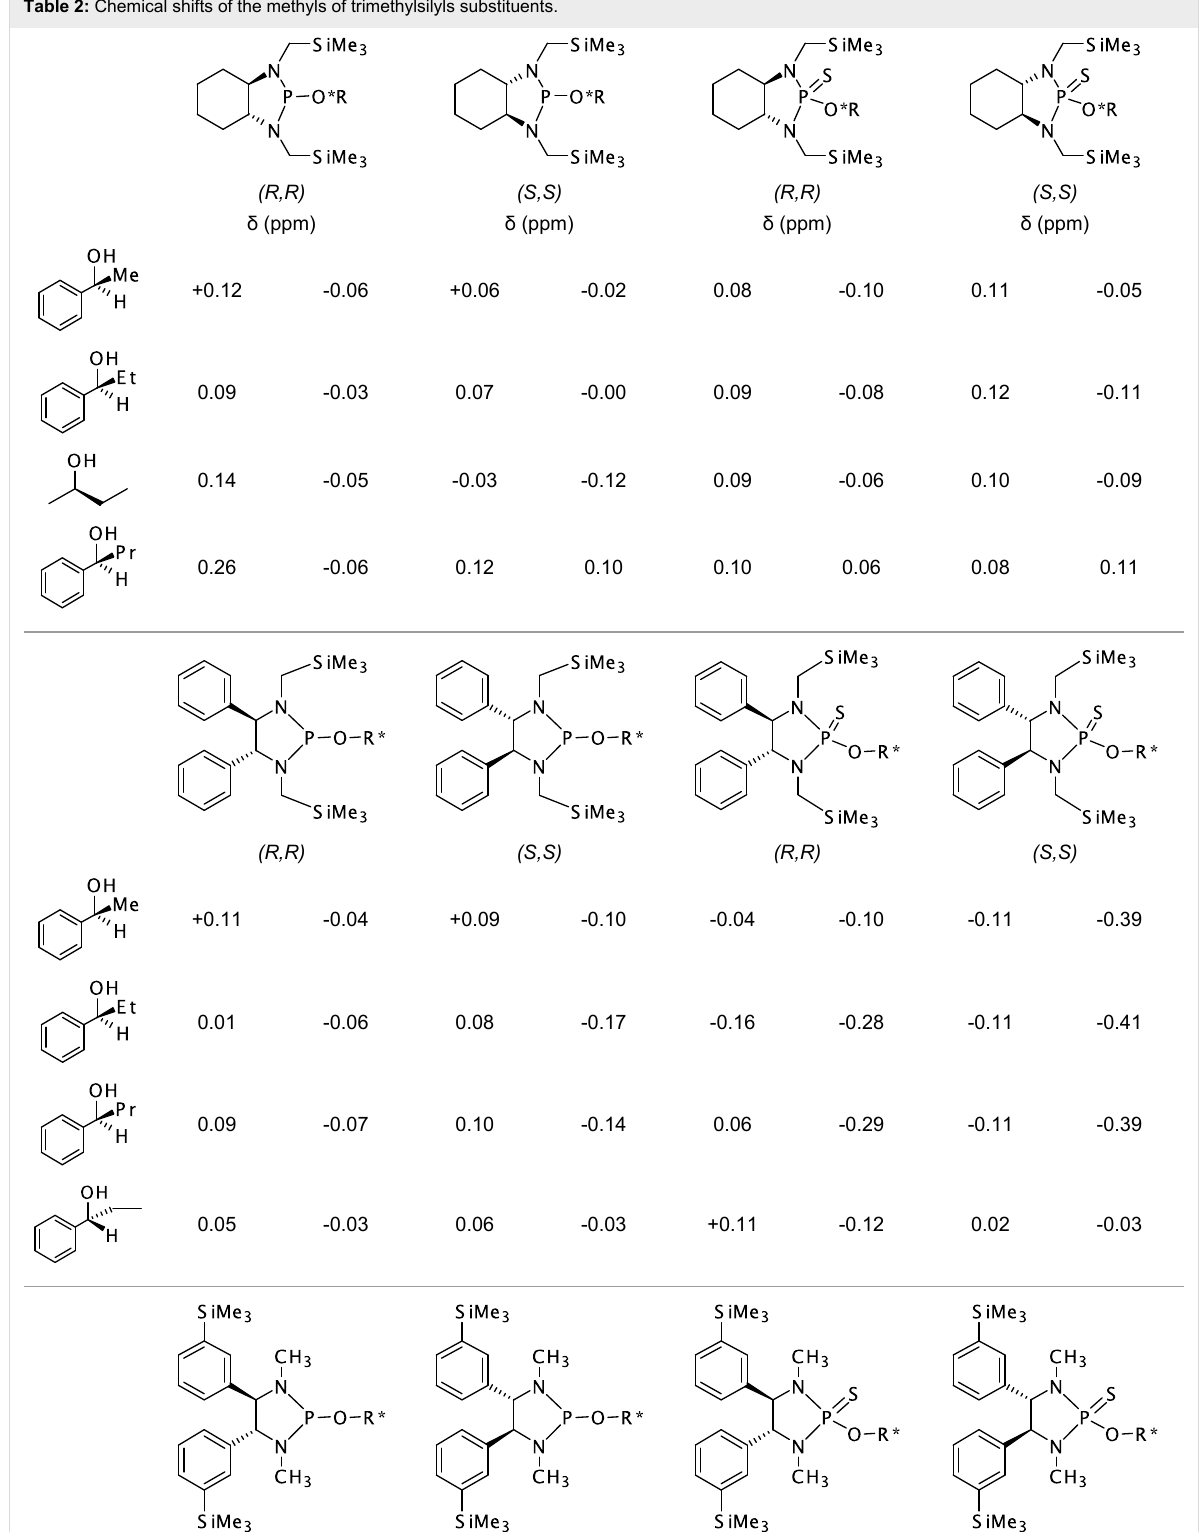
Table 2: Chemical shifts of the methyls of trimethylsilyls